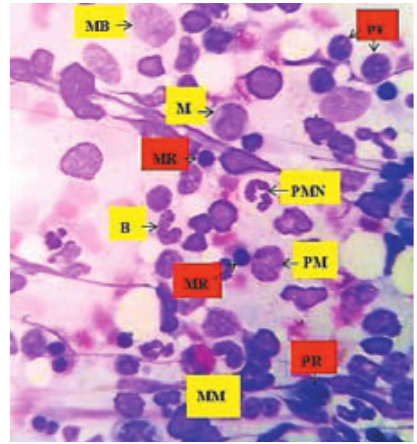
Fig. 8. Bone marrow cytological smear showing different myeloid and erythroid series of cells (Wright-Giemsa stain, 1000x) EB- Erythroblast; B- Band cells, PR – Prorubricyte, MR- Metarubricyte; RBCS-Red Blood Cells